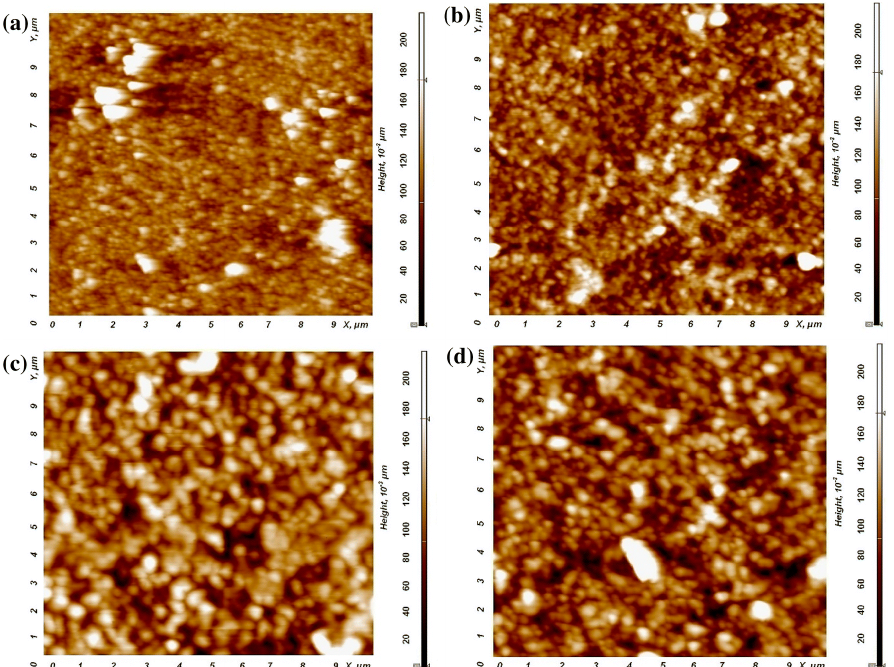
Figure 10. The 2D AFM images of Pr:AZO thin films with different doping levels: ( a ) 0%, ( b ) 0.5%, ( c ) 1%, and ( d ) 1.5%. Reproduced with permission from ref. [11].